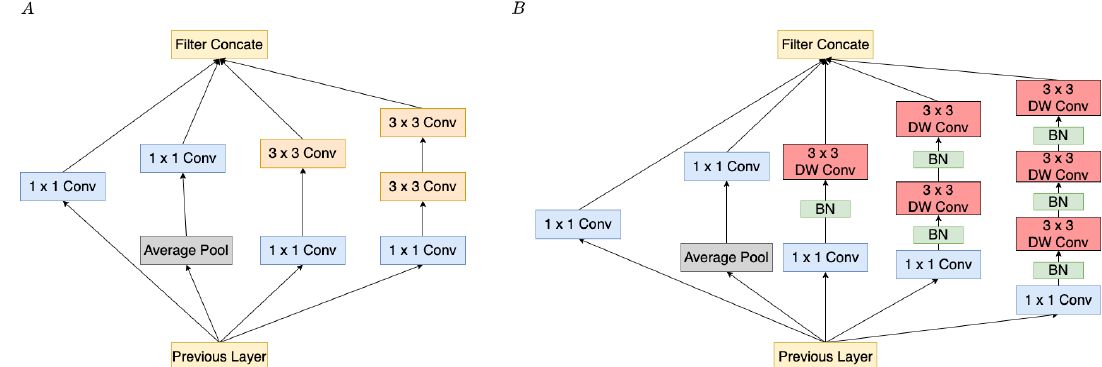
Figure 6. ( A ) shows the standard inception block. ( B ) represents the modified inception block. The difference between ( A , B ) is that ( B ) replaces the standard convolution with depthwise separable convolution. Moreover, the BN layer is introduced before the 3 × 3